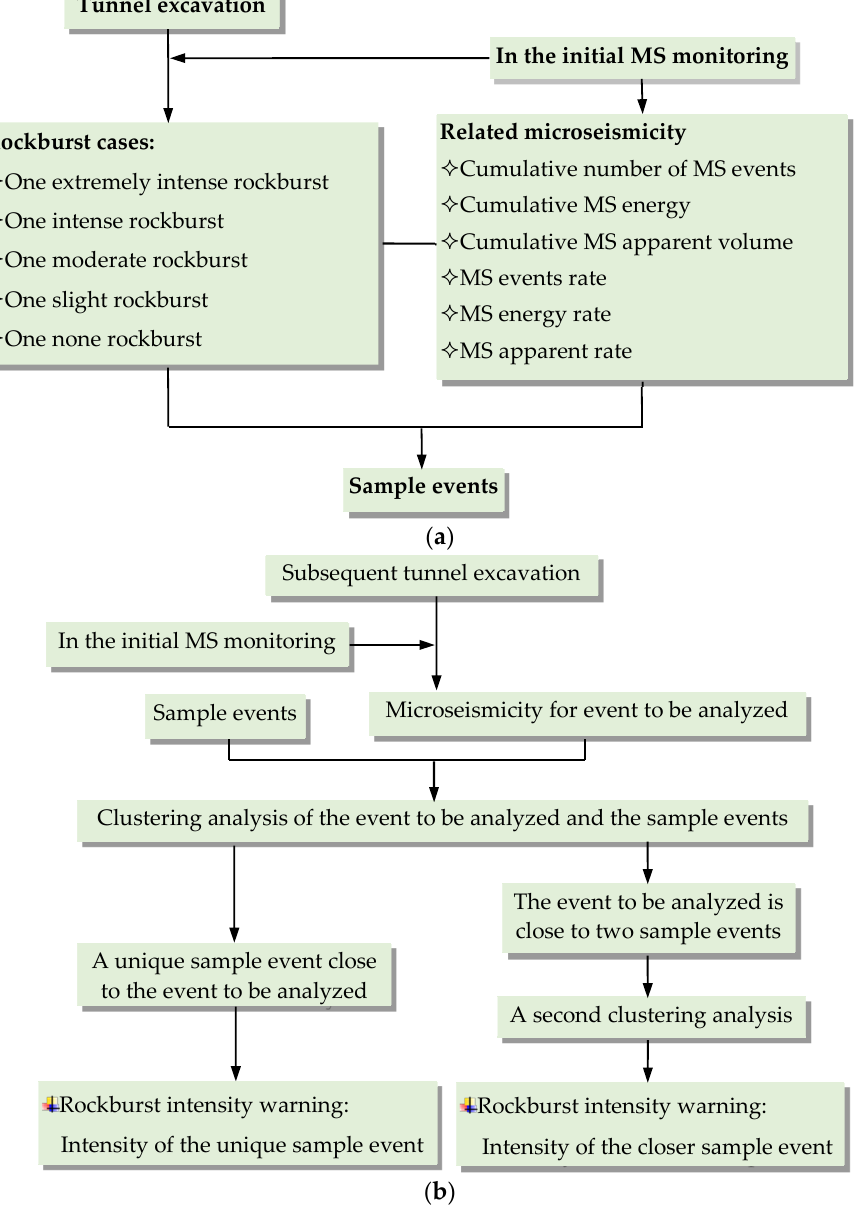
Figure 1. Flowcharts illustrating the processes involved in the MS rockburst intensity warning method in deep tunnels: ( a ) establishment of the set of sample events, and ( b ) generating rockburst intensity warnings during the subsequent tunnel excavation (in the initial MS monitoring period).